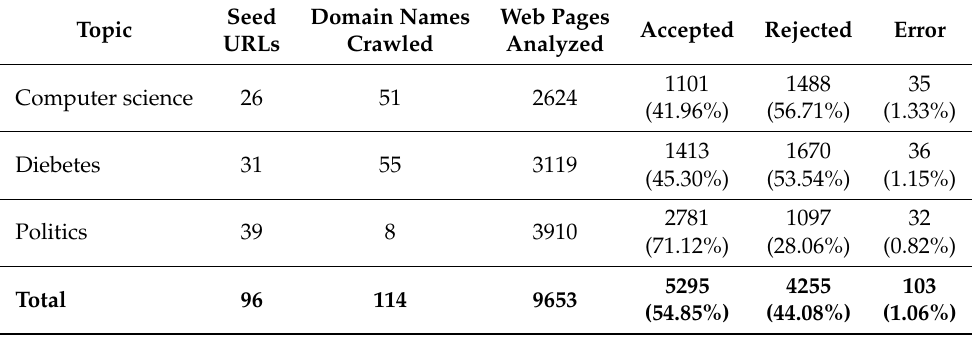
Table 7. Wikipedia results for crawled seed